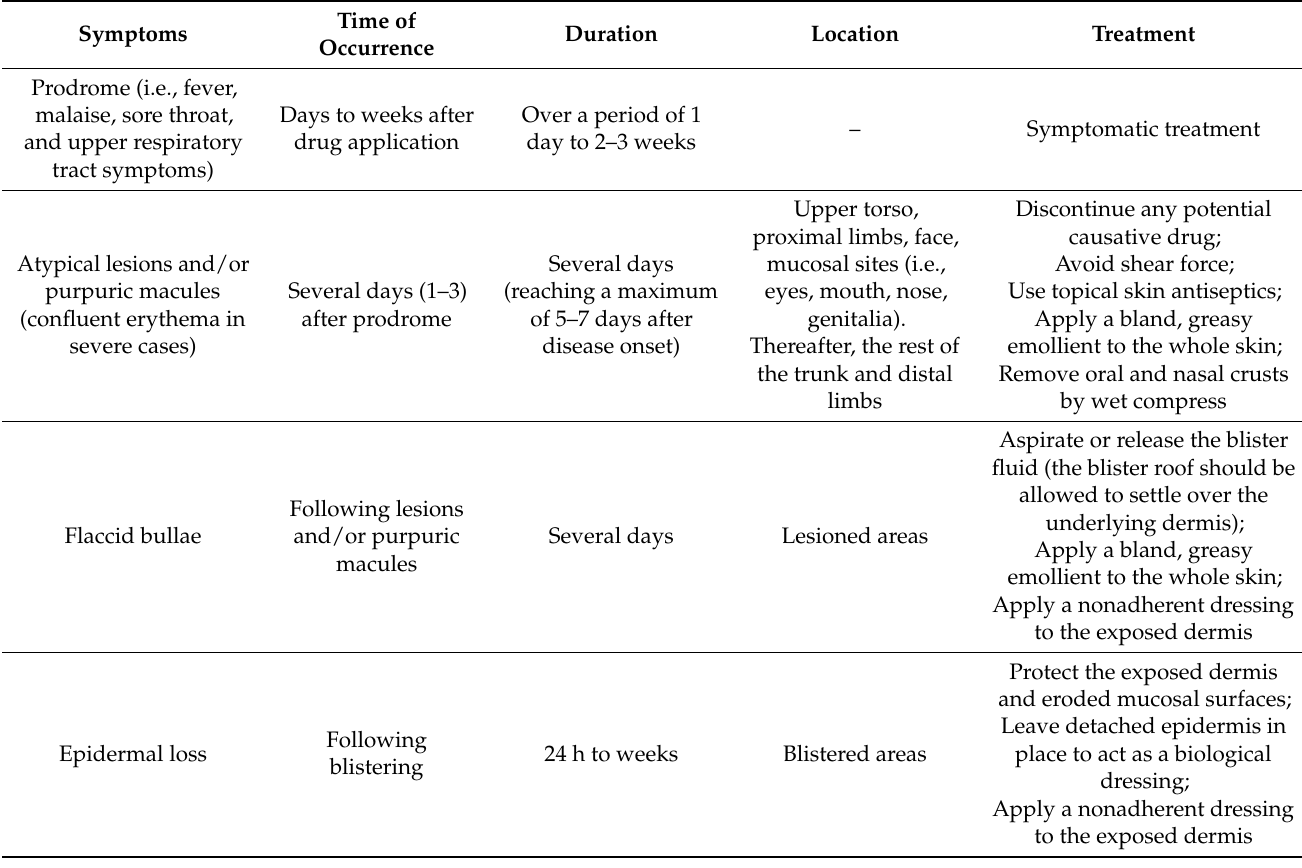
Table 1. Differentiation of TEN with other blistering